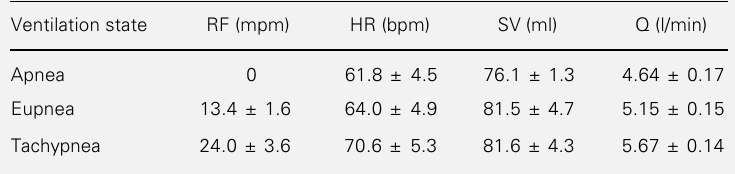
Table 1 - Measurement of ventilatory and circulatory parameters by echodopplercardi- ography. Data are reported as means – SEM for 5 normal young adult male volunteers. RF, Respiratory frequency; HR, heart rate; SV, stroke volume; Q, systemic blood flow.